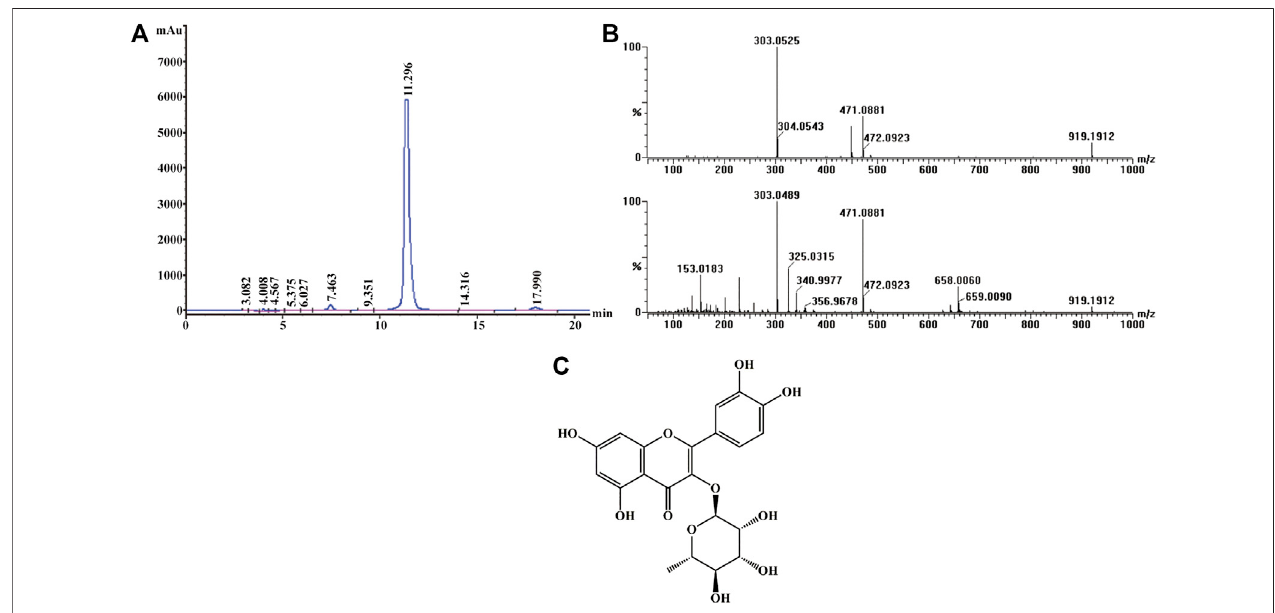
FIGURE 1 | Structural identi fi cation of quercitrin. (A) HPLC-UV chromatogram obtained at 210 nm. (B) MS (top) and MS/MS (bottom) data for quercitrin. (C) Structural formula of